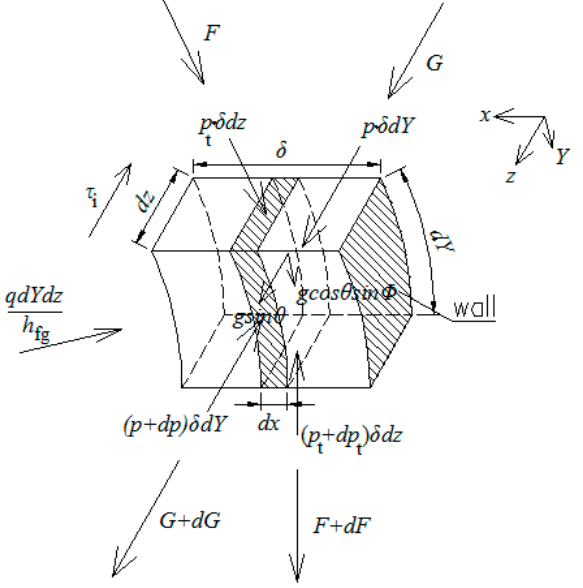
Figure 4. Schematic diagram of control volume of condensate film on inner wall of flat tube. F + ∂ F dY represents the control volume flux in lower reaches of y axis, and ∂ F ∂ Y increment of control volume flow in circumferential direction. In the same way, ∂ G increment of control volume flow in axial direction. The increment of mass flow of control volume derives from condensation during heat transfer process in heat transfer surface. Q is defined as